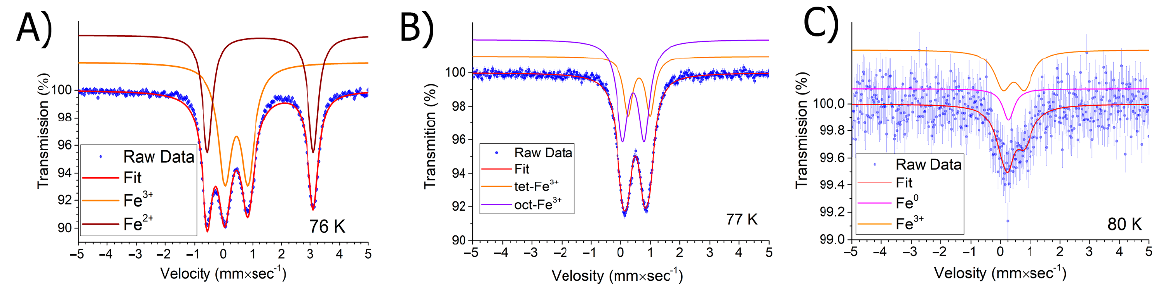
Figure 6. Mossbauer spectra of ( A ) ChemRed-NP; ( B ) US/TermRed-NP; ( C )